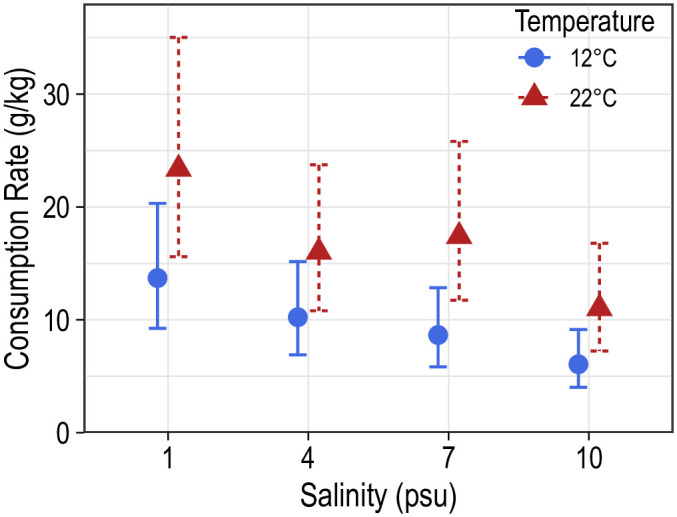
Mean consumption rates (g/kg) of juvenile blue catfish at two temperatures and four salinities.Error bars correspond to 95% confidence bands around the predicted consumption rates.